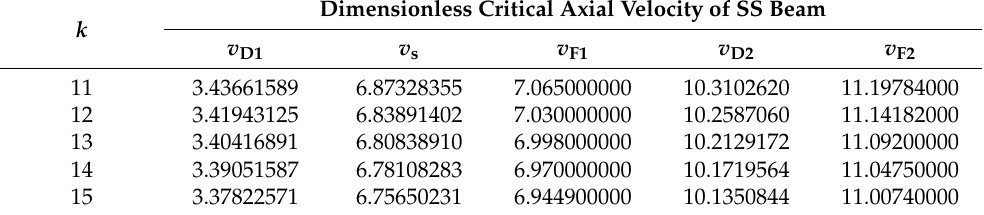
Table 5. The effects of gradient parameter k of material on the dimensionless critical axial velocities of FGM beam (SS).